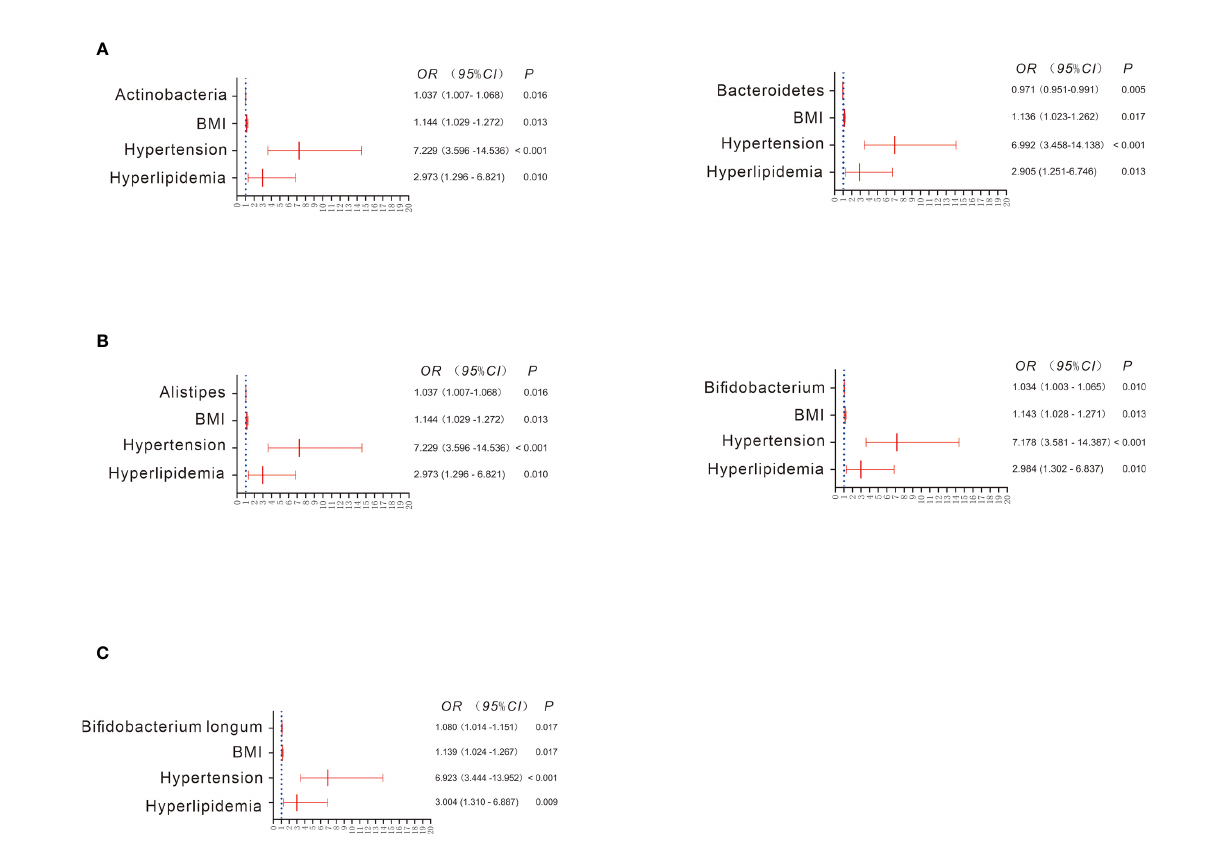
FIGURE 2 | Bacterial abundance showing a signi fi cant difference between the CKD and HC groups when adjusting for confounders (A – C) . Binary regression analysis was used to adjust for confounders of BMI, hypertension and hyperlipidemia. The estimated ORs and their CIs are displayed as forest graphs. The blue dotted line represents the OR value =